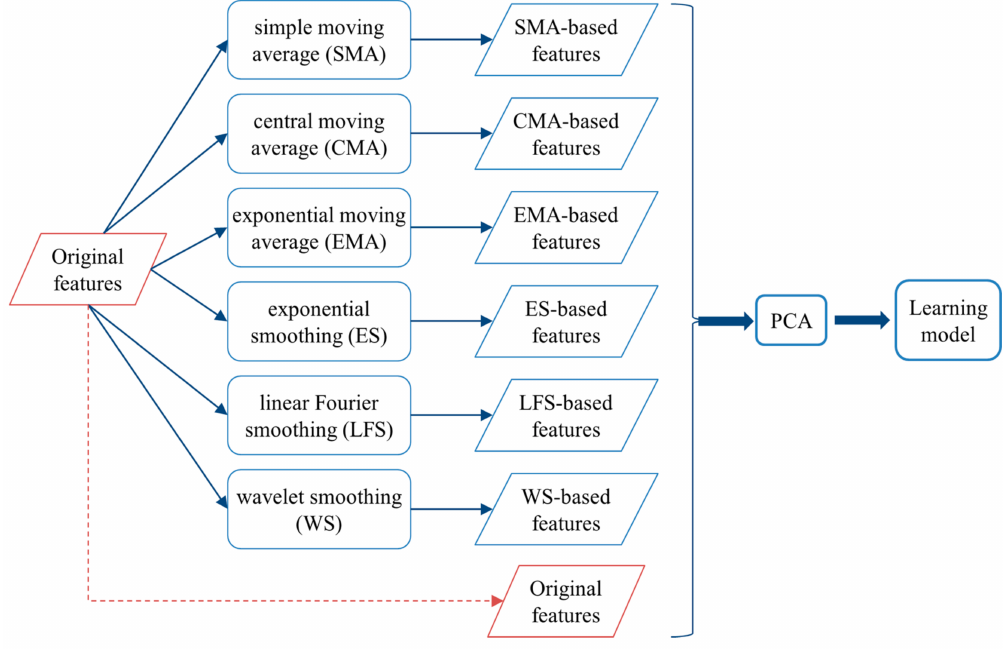
Figure 1. A flowchart of the proposed approach